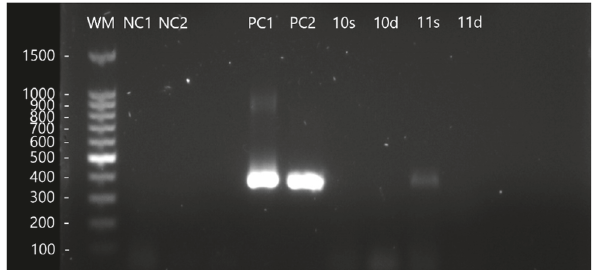
Figure 2: Agarose gel 1.5%. The well 11s (superficial) shows a positive amplification for T. gondii . WM: weight marker, NC1: negative control one, NC2: negative control two, PC1: positive control one (1x10 2 tachyzoites/mL), PC2: positive control two (1x10 3